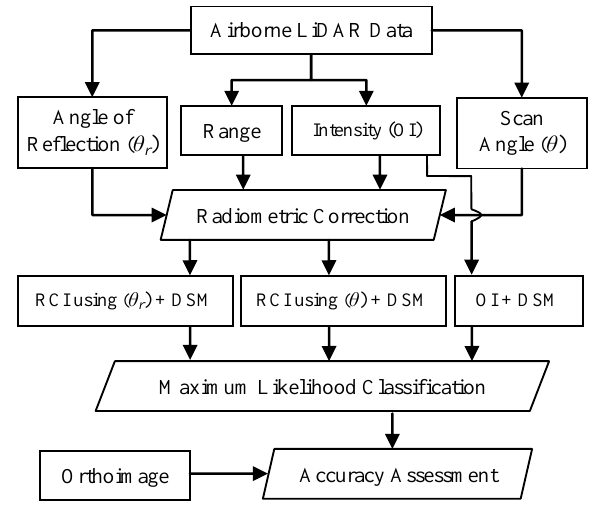
Figure 3. Experimental workflow